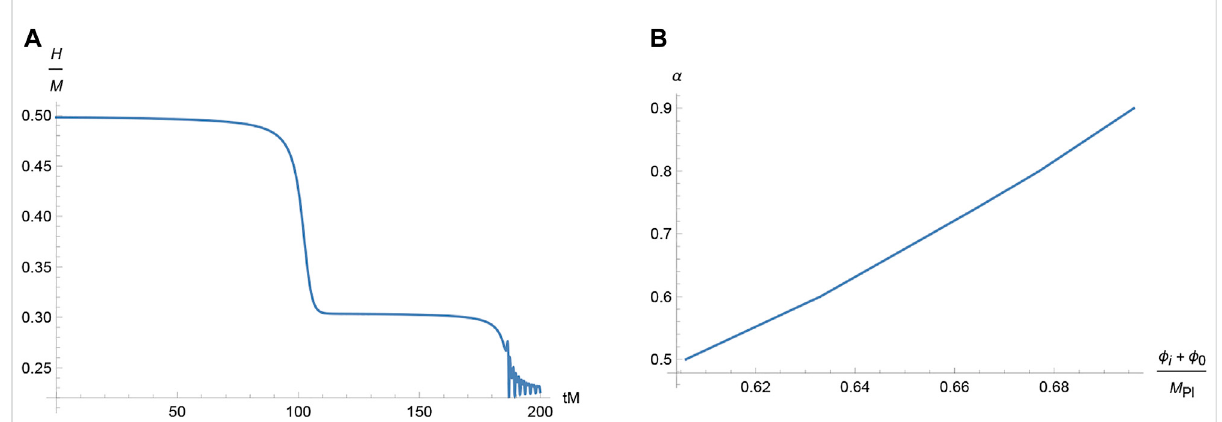
FIGURE 2 The Hubble function H (A) and the relation between the parameters ϕ i and α for the power spectrum enhancement and PBHs production (B) .